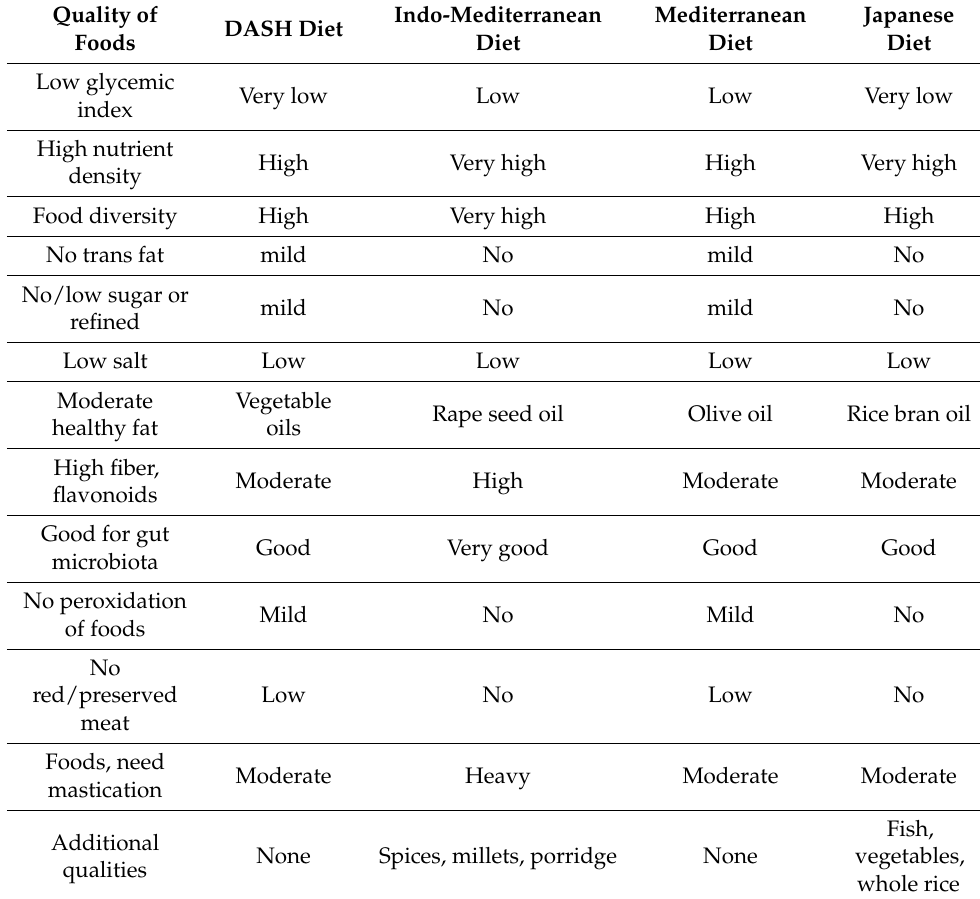
Table 3. The twelve qualities of the other high-quality diets, compared to the DASH